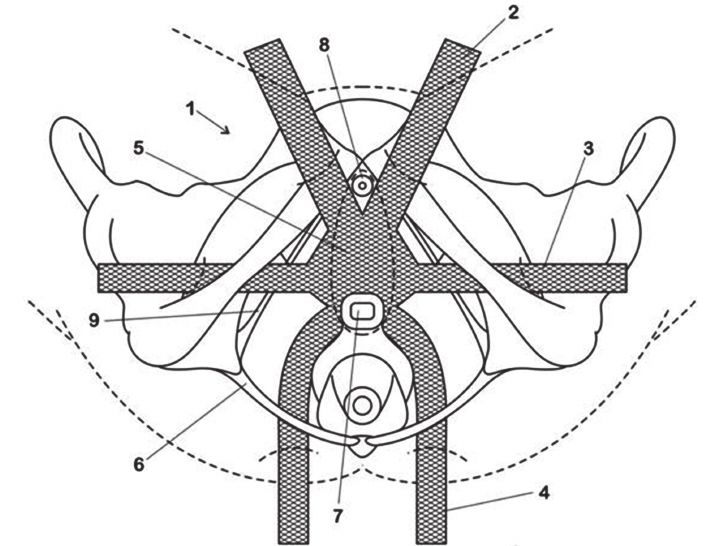
figure 1 - Antero apical mesh configuration: 1) the mesh;2) pre pubic arms;3) transobturator arms;4)sacrospinous ligament arms;5) body of the mesh;6) sacrospinous ligament;7) uterus cervix or vaginal vault;8) urethra;9) arcus